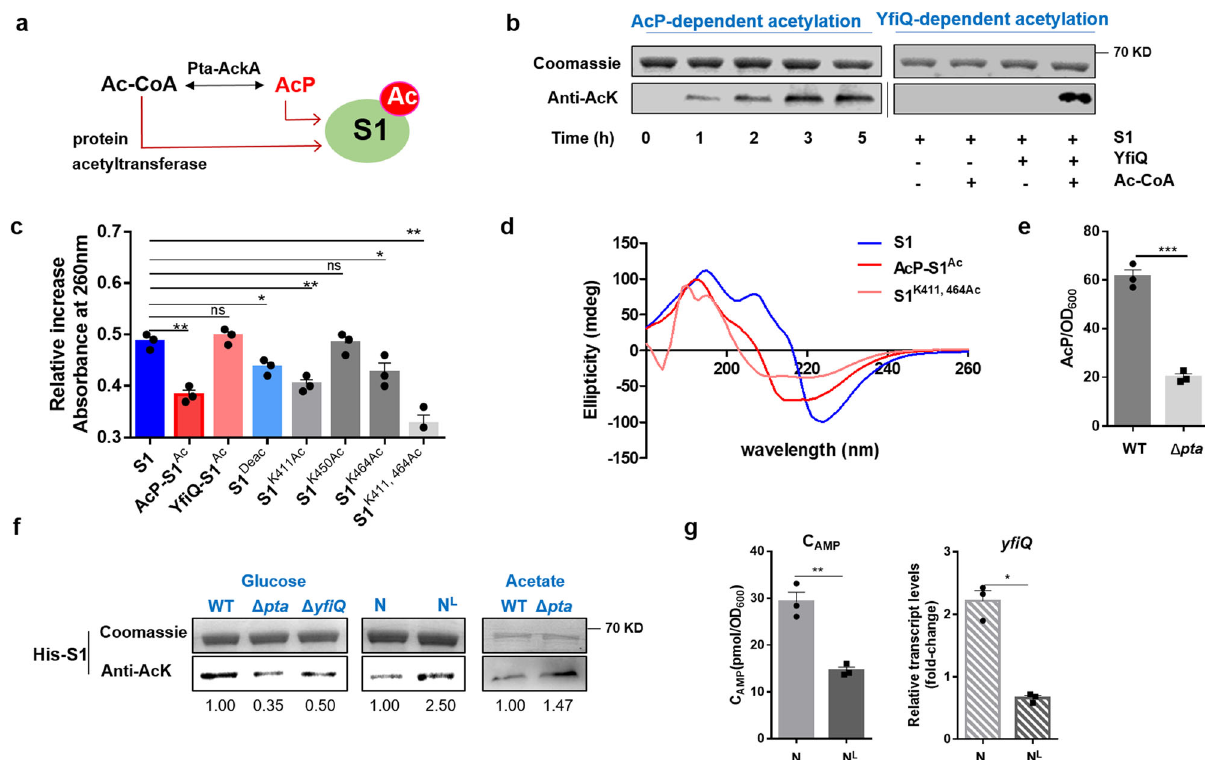
Fig. 1 AcP-dependent acetylation of S1 regulated its function. a S1 acetylation via two mechanisms: enzymatic acetylation relies on a protein acetyltransferase (Y fi Q) and chemical acetylation based on acetyl phosphate (AcP). b Puri fi ed His-S1 was acetylated by AcP or Y fi Q in vitro. c Effect of S1 (WT-S1) and acetylated S1 (AcP-acetylated S1, AcP-S1 Ac ; Y fi Q-acetylated S1, Y fi Q-S1 Ac ; S1 Deac , AcP-acetylated S1 was deacetylated by CobB; Site- speci fi cally lysine acetylated proteins S1 K411Ac , S1 K450Ac , S1 K464Ac and S1 K411, 464Ac ) on the induction of hyperchromicity in poly(rC-U). * P < 0.05, ** P < 0.01, *** P < 0.001. Three replicates were made for each sample. d Circular dichroism spectra of S1, AcP-S1 Ac and site-speci fi cally lysine acetylated protein S1 K411, 464Ac . e AcP concentrations of WT::S1 and Δ pta ::S1 cultured in glucose. AcP concentration was normalized to OD 600 . * P < 0.05, ** P < 0.01, *** P < 0.001. Three replicates were made for each sample. f Acetylation levels of overexpressed S1 in WT, pta -deleted mutant Δ pta and y fi Q -deleted mutant Δ y fi Q cultured in glucose or acetate; Acetylation levels of overexpressed S1 in E. coli cultured in N (standard nitrogen) or N L (limited nitrogen). The band intensities were quanti fi ed by densitometry using Image J software. g Relative transcript levels of y fi Q and concentration of cAMP in E. coli cultured in N and N L at 14 h. * P < 0.05, ** P < 0.01, *** P < 0.001. Three replicates were made for each